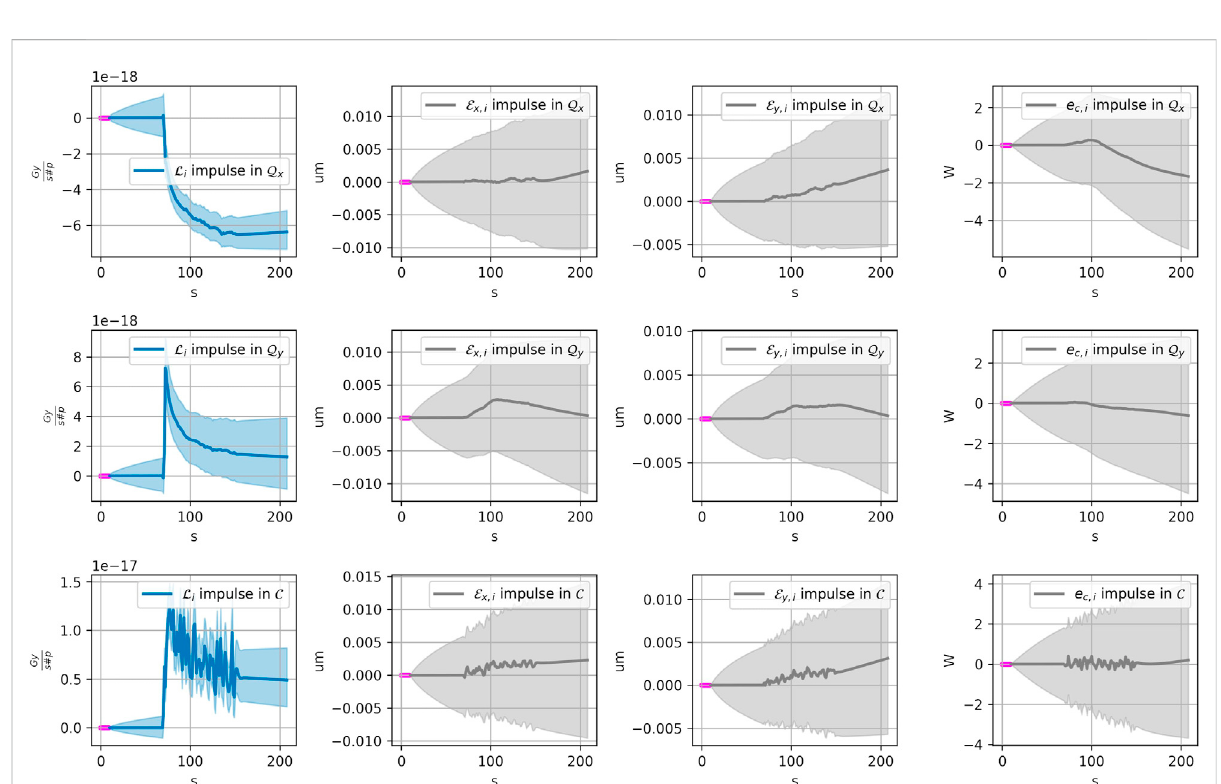
Impulse response plots for (KF4) model, impulses in the input parameters: in horizontal and vertical tunes and in the octupole current. The changes in losses and (2 σ -)con fi dence intervals produced by (KF4) are shown in blue colors. The changes in the rest of the output components (horizontal and vertical emittances and electron cloud induced heatloads) and corresponding (2 σ -)con fi dence intervals are shown in